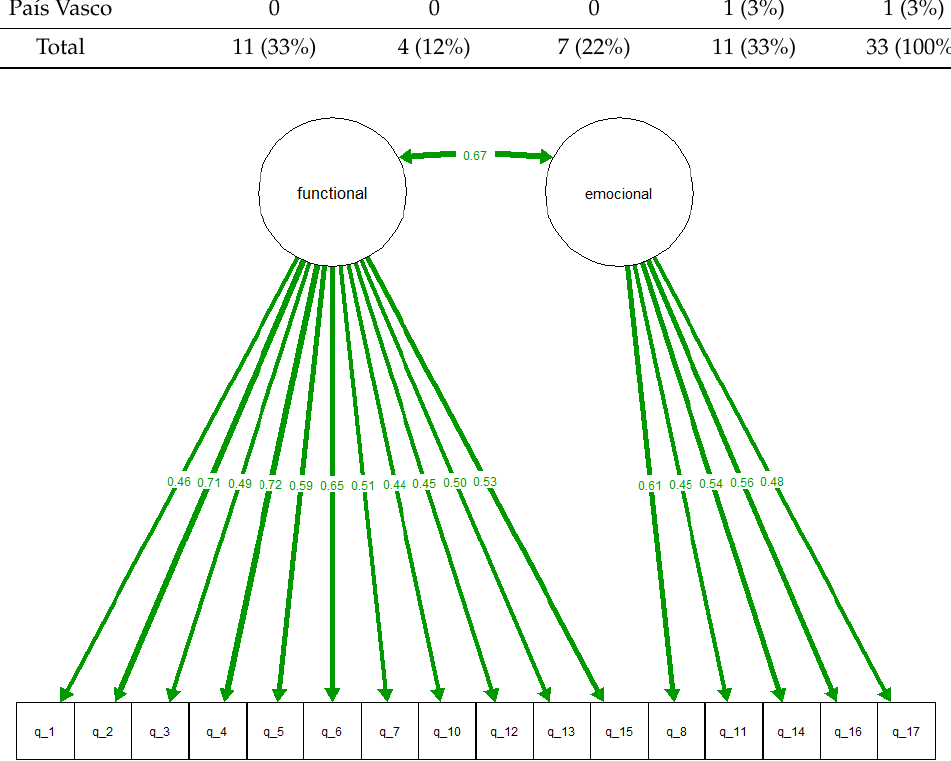
Figure 1. Confirmatory factor analysis of the results of the Spanish version of the